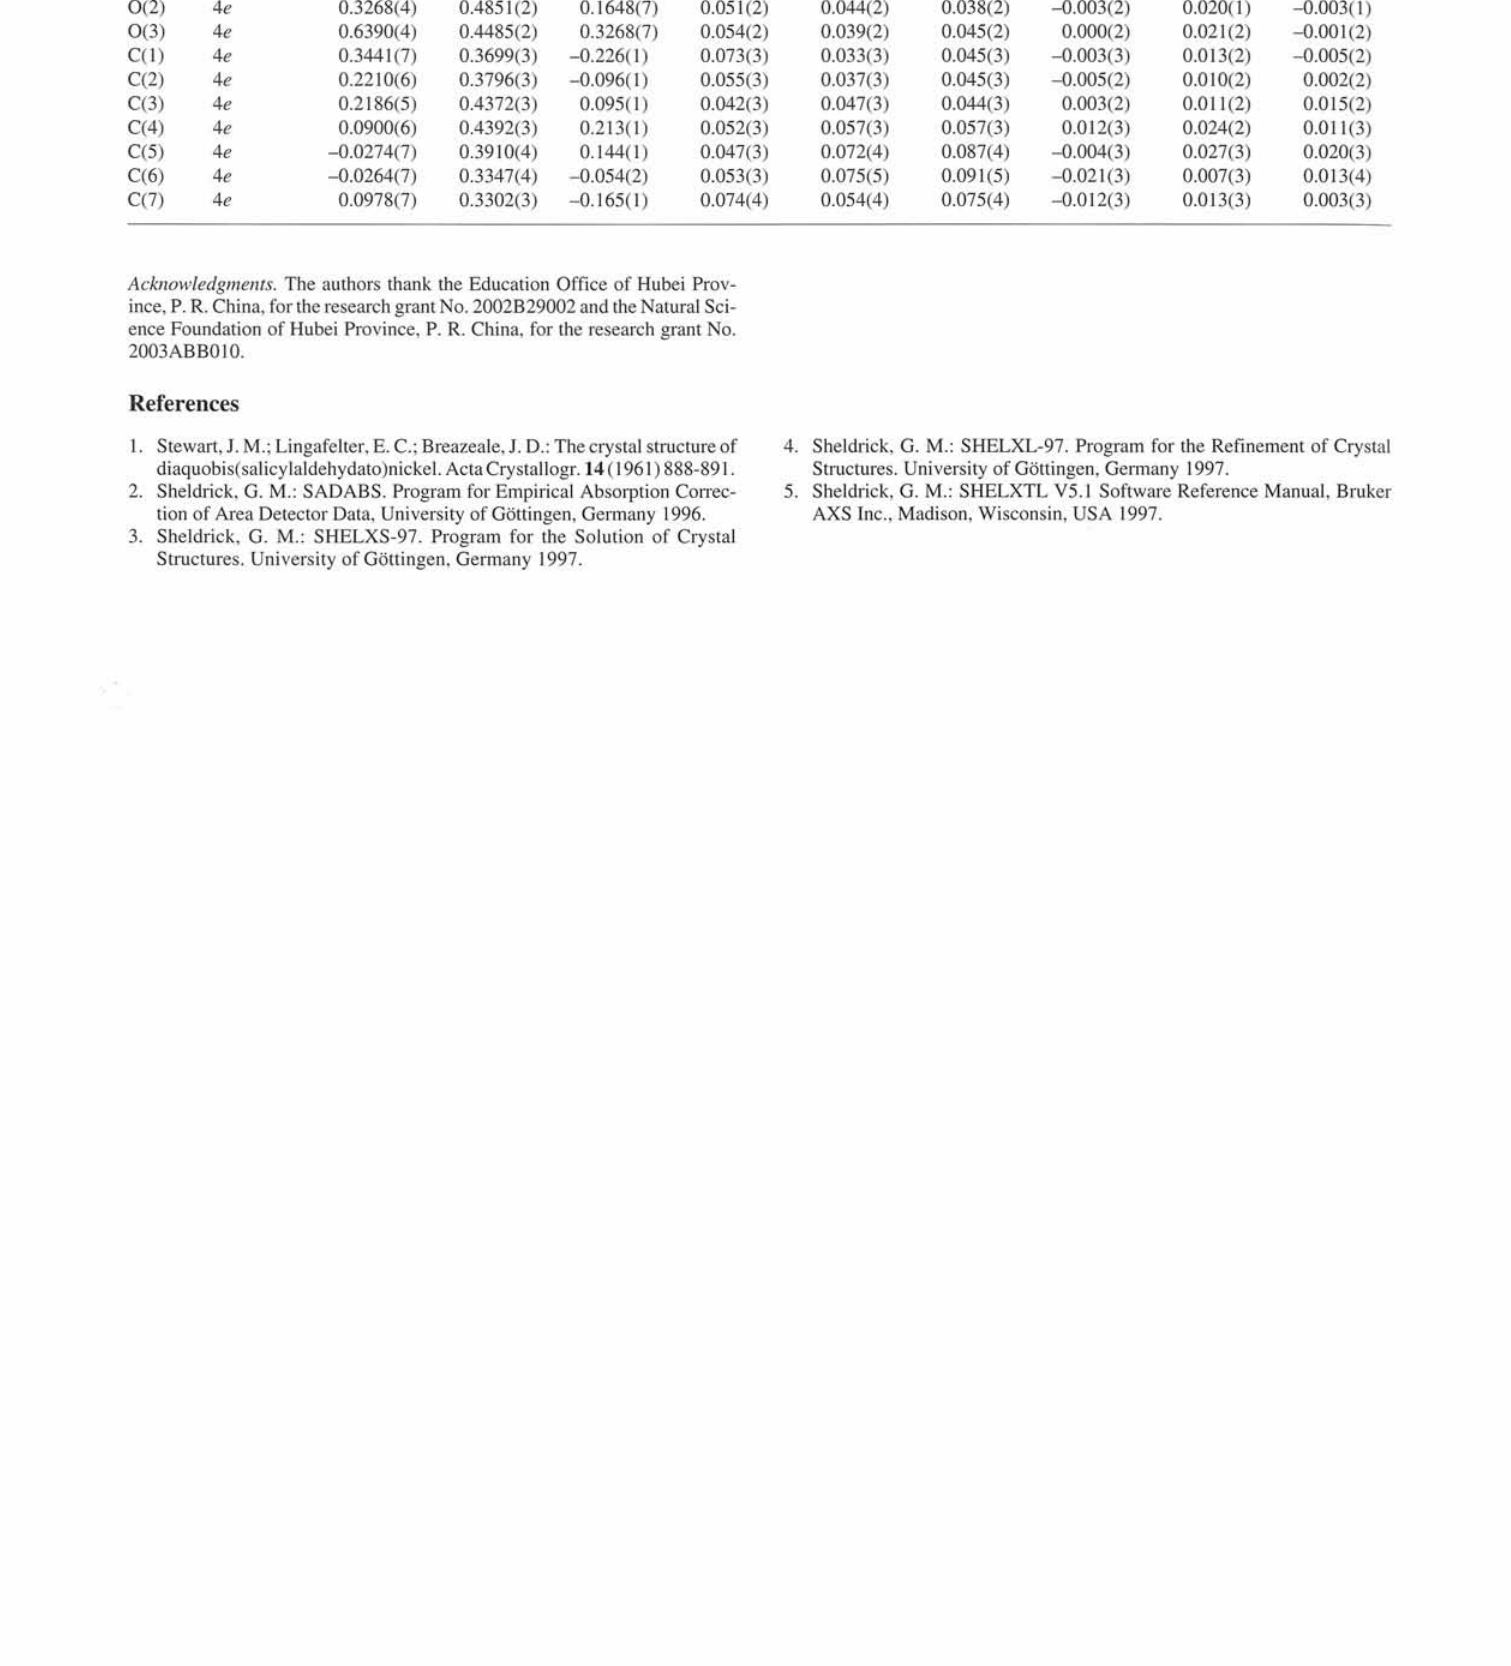
Table 3. Atomic coordinates and displacement parameters (in Â 2